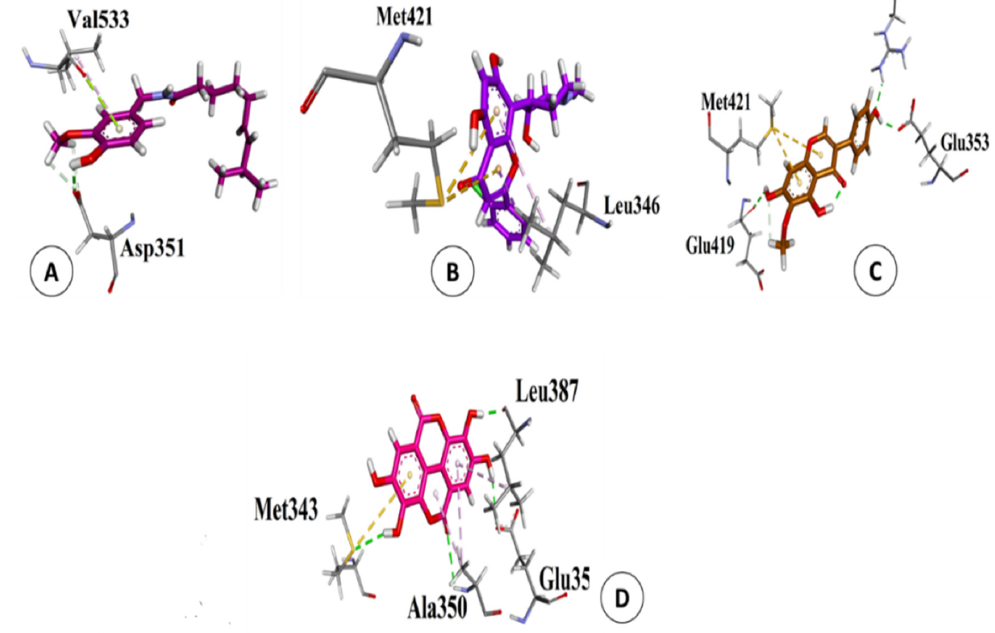
Figure 5. Three-dimensional interactions of natural compounds capsaicin ( A ), flavopiridol ( B ), tectorigenin ( C ), ellagic acid ( D ) with binding site of ER α protein. ( D ) with binding site of ER α